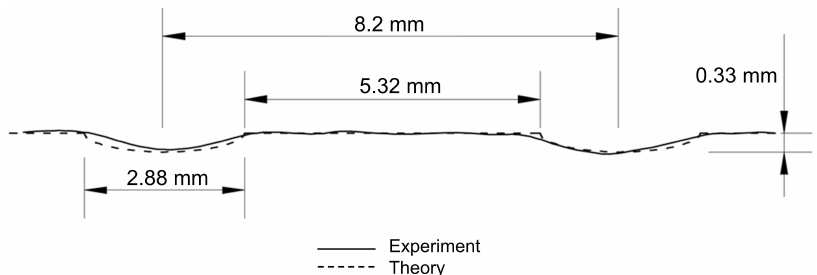
Figure 13. Comparison of the theoretically calculated oscillation mark profiles and those measured experimentally by Saleem